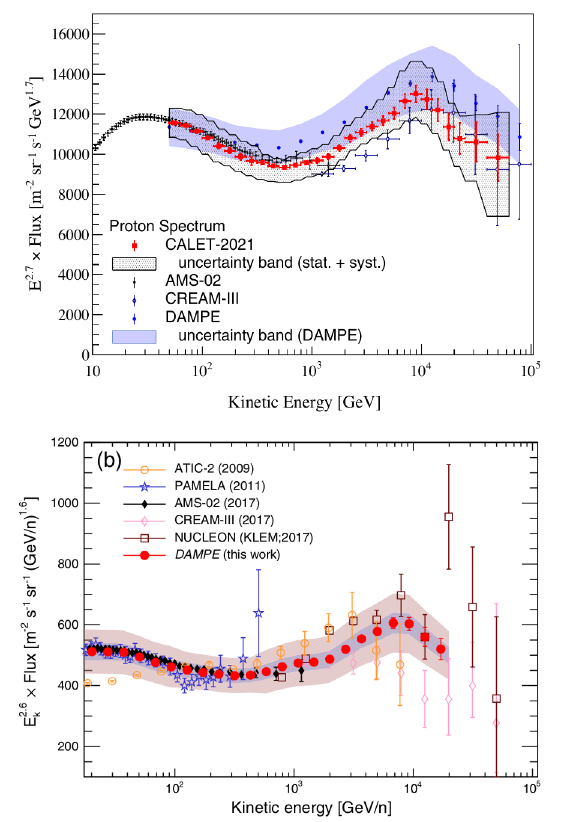
Figure 4. Proton and Helium fluxes measured by di ff erent ex- periments [11] [15].